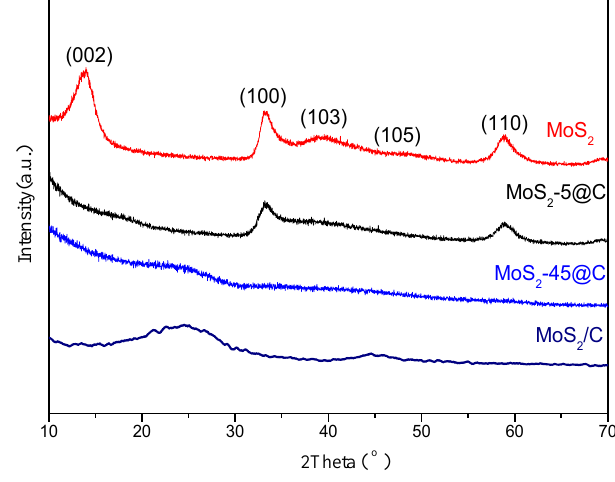
Figure 1. XRD patterns of MoS 2 samples.